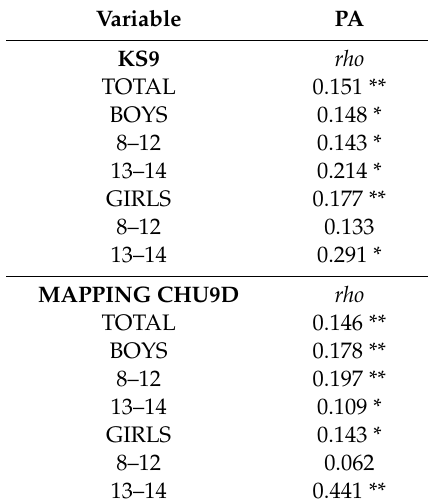
Table 5. Pearson’s bivariate correlation between PA and HRQoL (KS9 and MAPPING CHU9D).